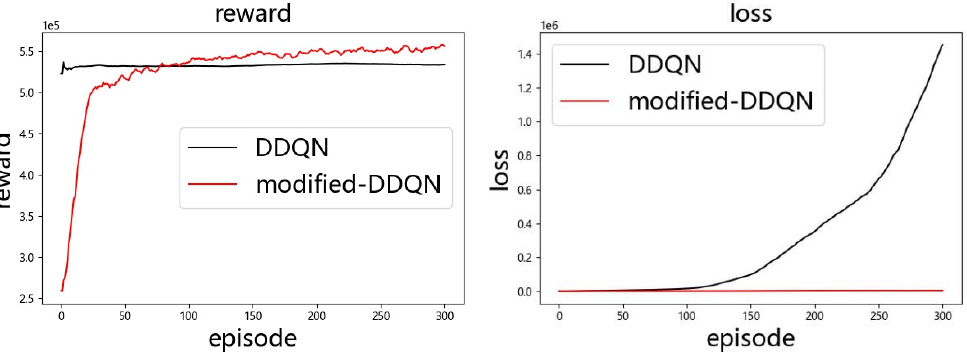
Figure 6. Production scheduling simulation reward function curve and simulation loss function curve.